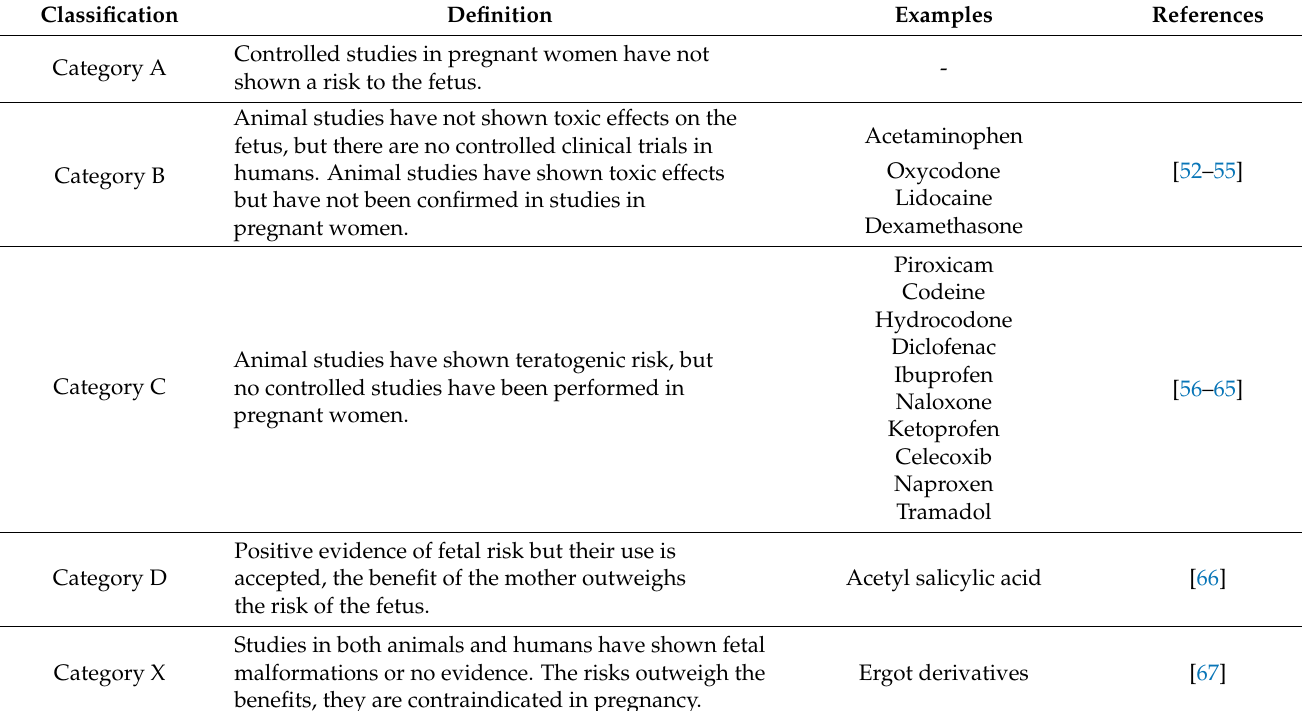
Table 1. The FDA’s classification of drugs used in pain management regarding pregnancy